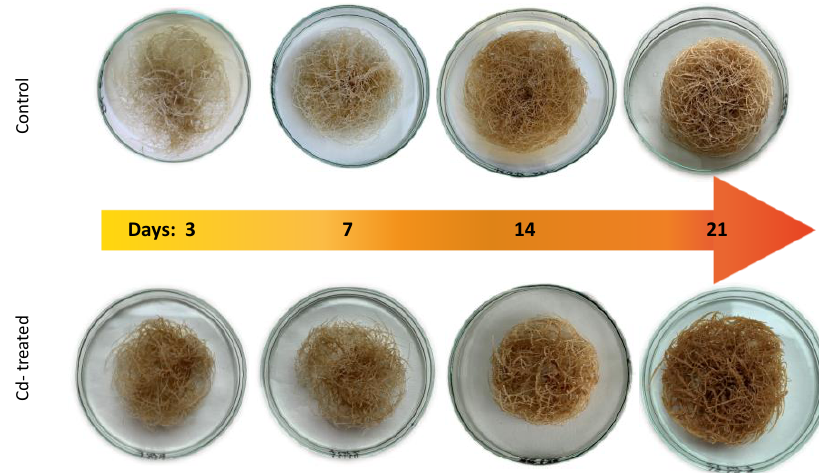
Figure 2. Cadmium-induced morphological changes in hairy roots.